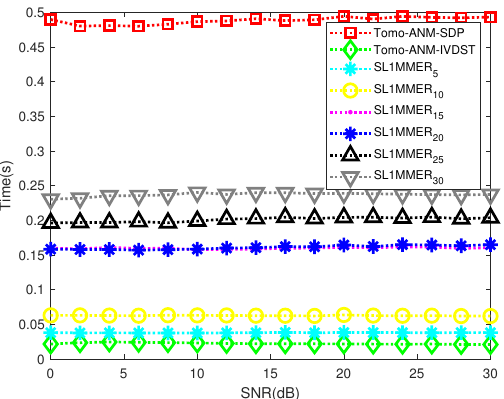
Figure 9. Running time of single scatterer of different methods under different